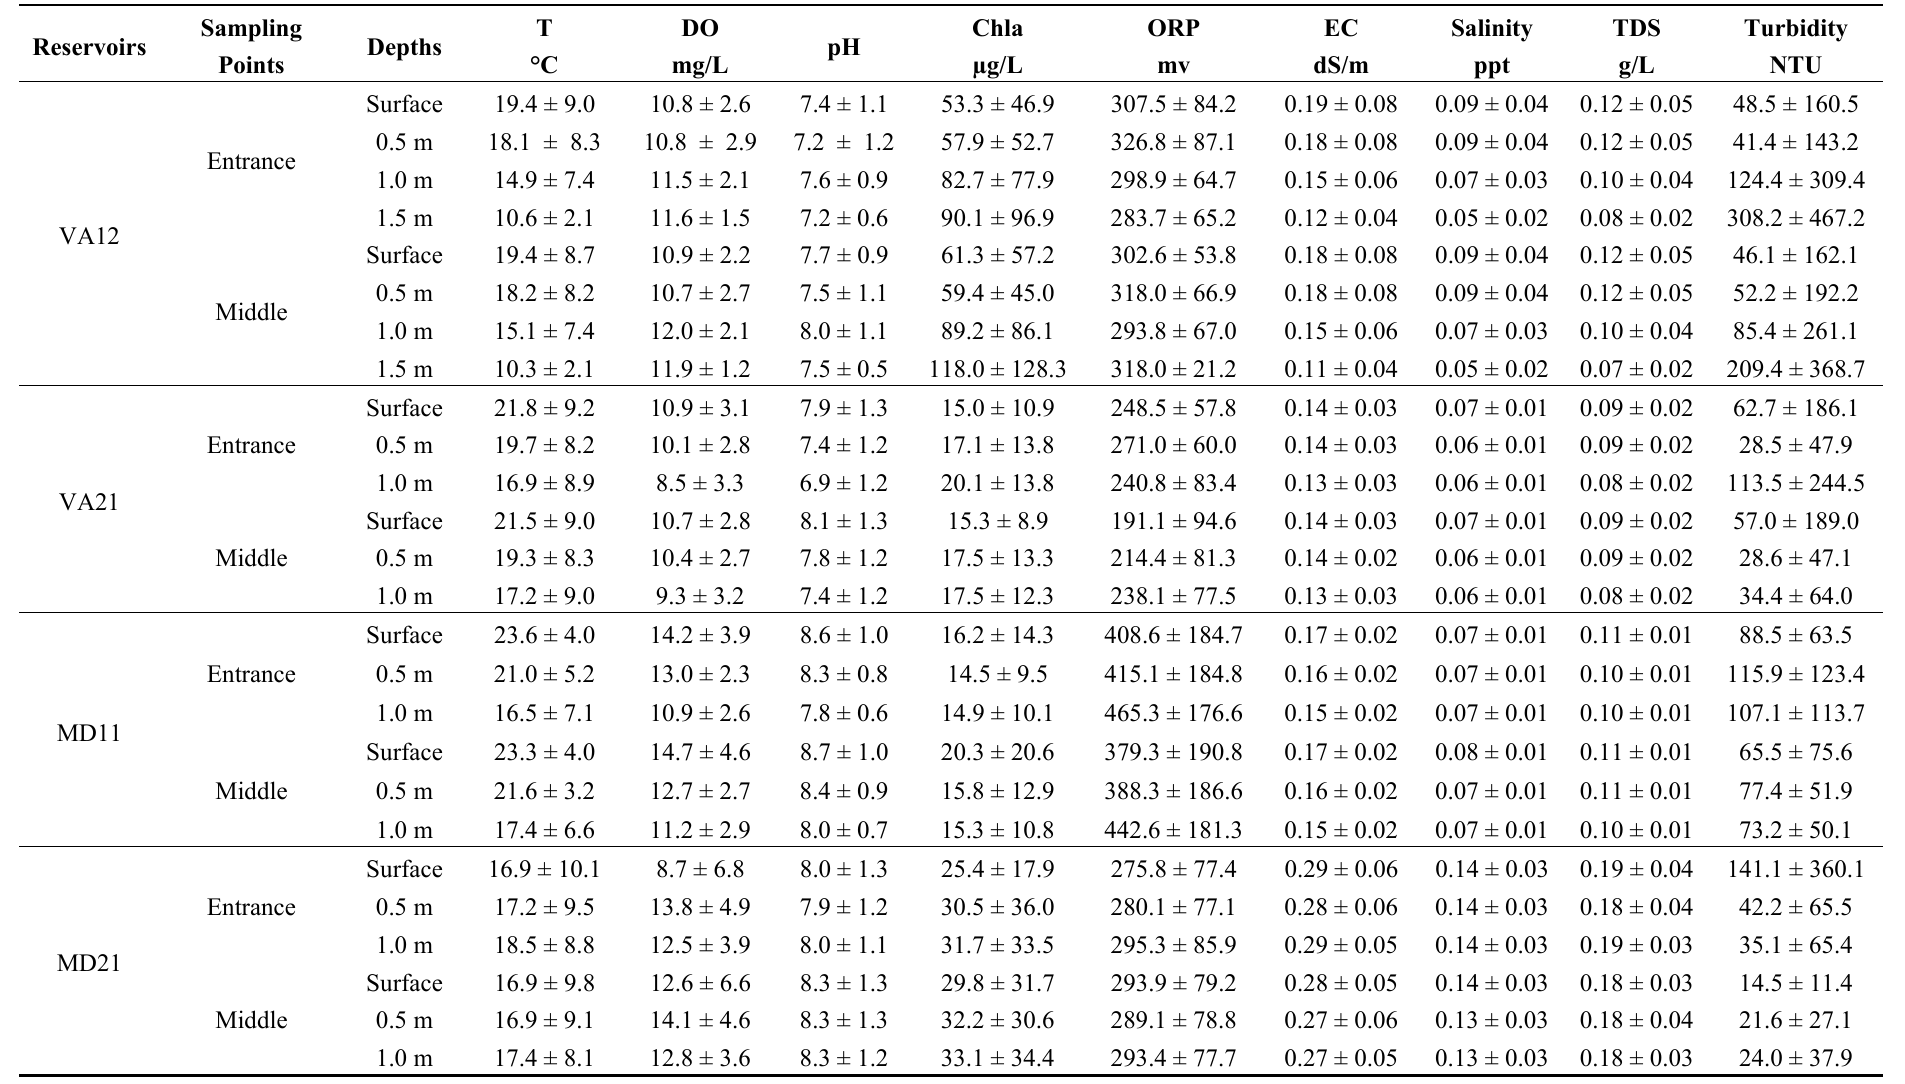
Table 2. The range of water quality parameters measured at two sampling points and at all depths in four RIRs during the 2011 to 2014 sampling period. Sampling Reservoirs